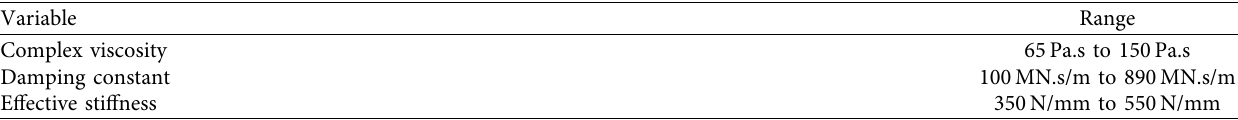
Table 2: Response variables’ resulting working range.